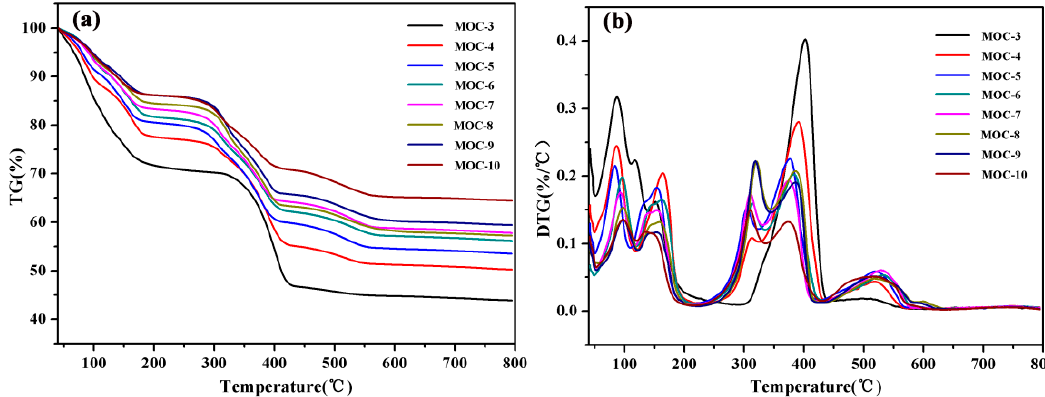
Figure 5. The ( a ) thermogravimetric (TG); and ( b ) derivative thermogravimetric (DTG) curves of the MOC adhesives.